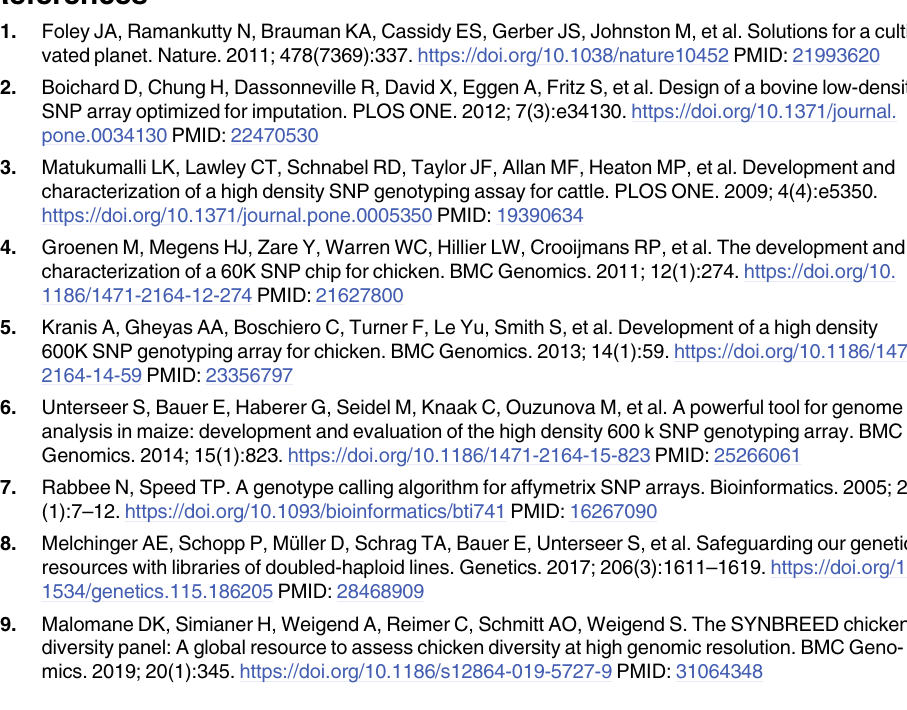
S1 Fig. Error rates depending on the allele frequency of the given variant depending on the used imputation pipeline when comparing to 30X sequencing data. S2 Fig. Allele frequency spectrum of the different genomic